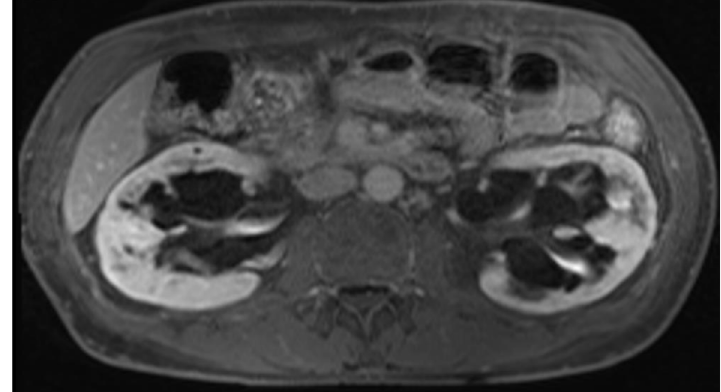
Figure 2. Parapelvic cysts in Fabry disease. MRI scan of proband from family C demonstrating bilateral parapelvic cysts.